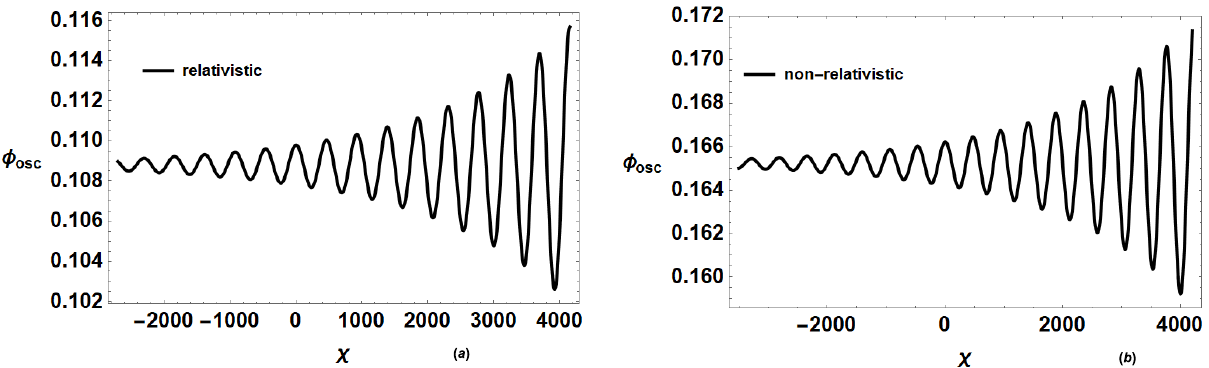
Figure 6. (Color online) Variation of oscillatory shock waves for different values of relativistic factor ( γ b ) ( a ) for the relativistic case ( γ b = 0.2) ( b ) for the nonrelativistic case ( γ b = 0), with fixed values of l z = 0.6, η = 0.05, V b 0 = 0.4, µ b = 0.2, H = 0.2 and T =